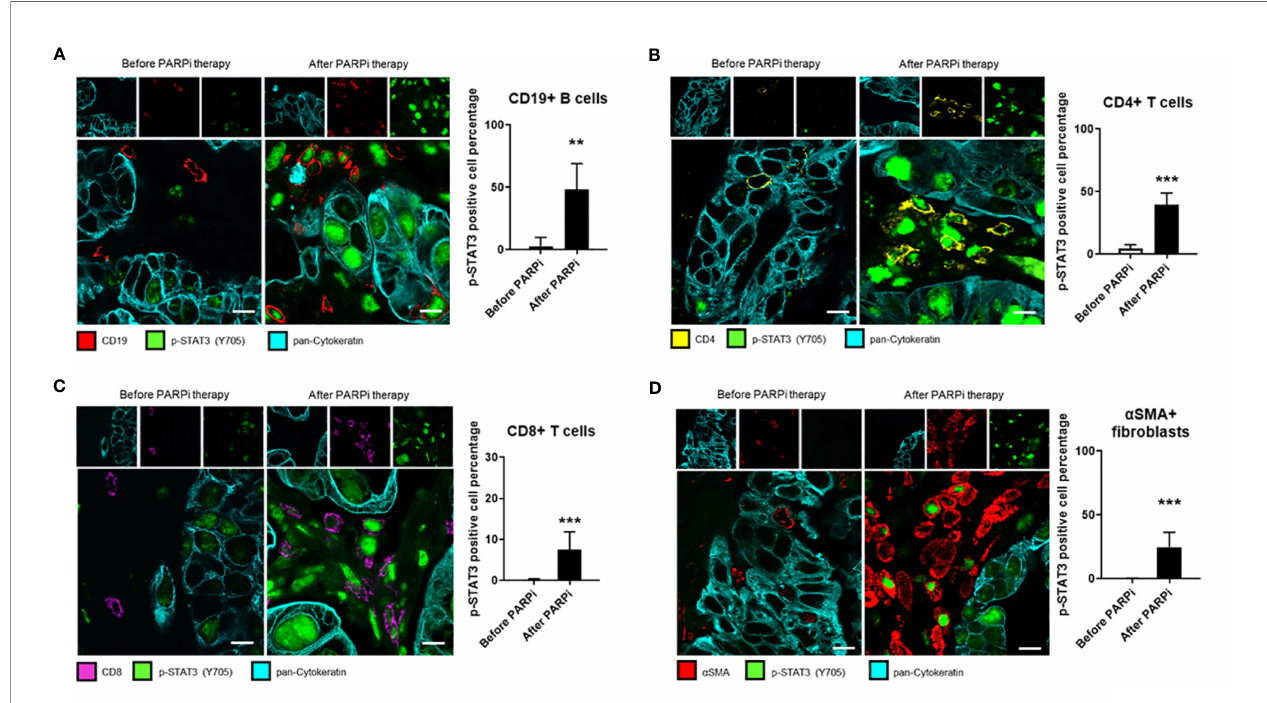
FIGURE 3 | STAT3 activity in ovarian cancer patient tumor-associated immune cells and fi broblasts is elevated post PARPi treatment. Representative immuno fl uorescence images of tumor sections from six gBRCA ovarian cancer patients before and after PARPi treatment showing p-STAT3 (green), pan-Cytokeratin (cyan), and either CD19+ B cells (red) in (A) , CD4+ T cells (yellow) in (B) , CD8+ T cells (magenta) in (C) or a SMA+ cancer-associated fi broblasts (red) in (D) . Cytokeratin-stained cell clusters represent malignant tissue. Scale bars = 10 m m. Histograms (right) showing p-STAT3 expressing cell percentage within indicated populations. Unpaired two-tailed Student t-test performed against the before treatment group. Results represent means ± SD, n = 9 (nine images acquired before and nine images acquired after PARPi treatment from the same patient, six patients total). **p<0.01,